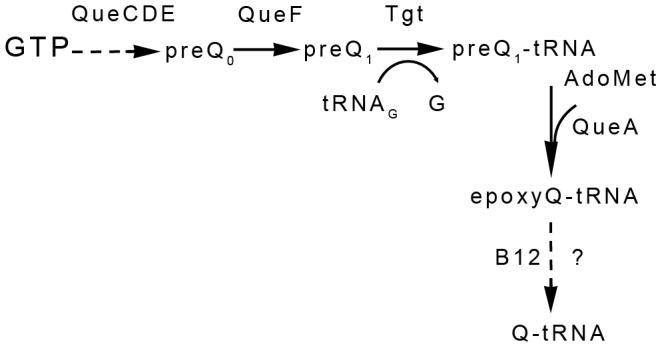
The S. meliloti queuosine biosynthetic pathway.preQ0: 7-cyano-7-deazaguanine, preQ1: 7-(aminomethyl)-7-deazaguanine, AdoMet: S-adenosyl-L-methionine, EpoxyQ: epoxyqueuosine, Q: queuosine. Adapted from [49], [50].